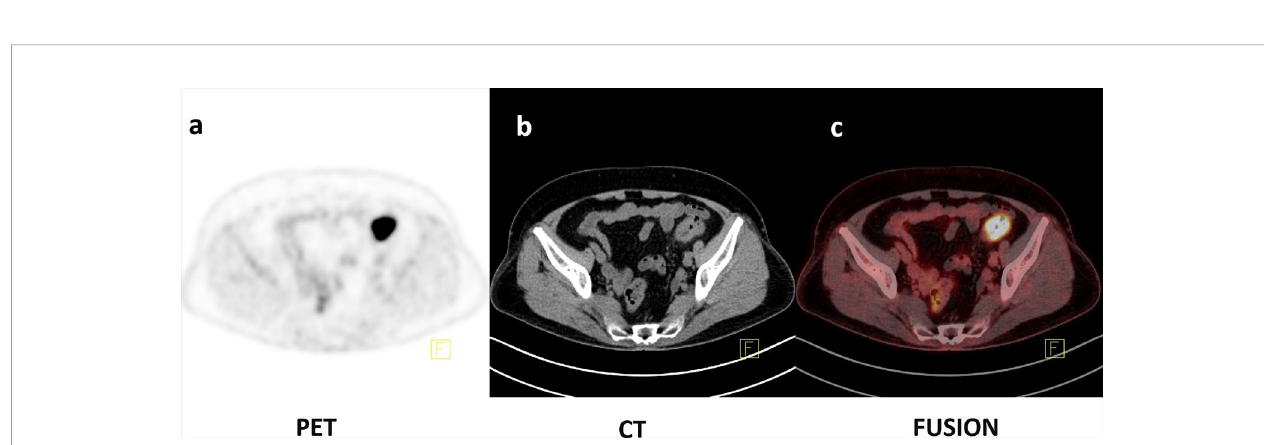
FIGURE 4 | Axial PET, CT, and fusion images of a 77-year-old female with histopathologically proven CRC with MSS (A – C) . 18 F-FDG PET/CT images showed that intense uptake in the sigmoid colon (SUV max = 22.58, SUV peak = 15.13, SUV mean50% = 14.64, MTV 50% = 5.63 ml, TLG 50% =